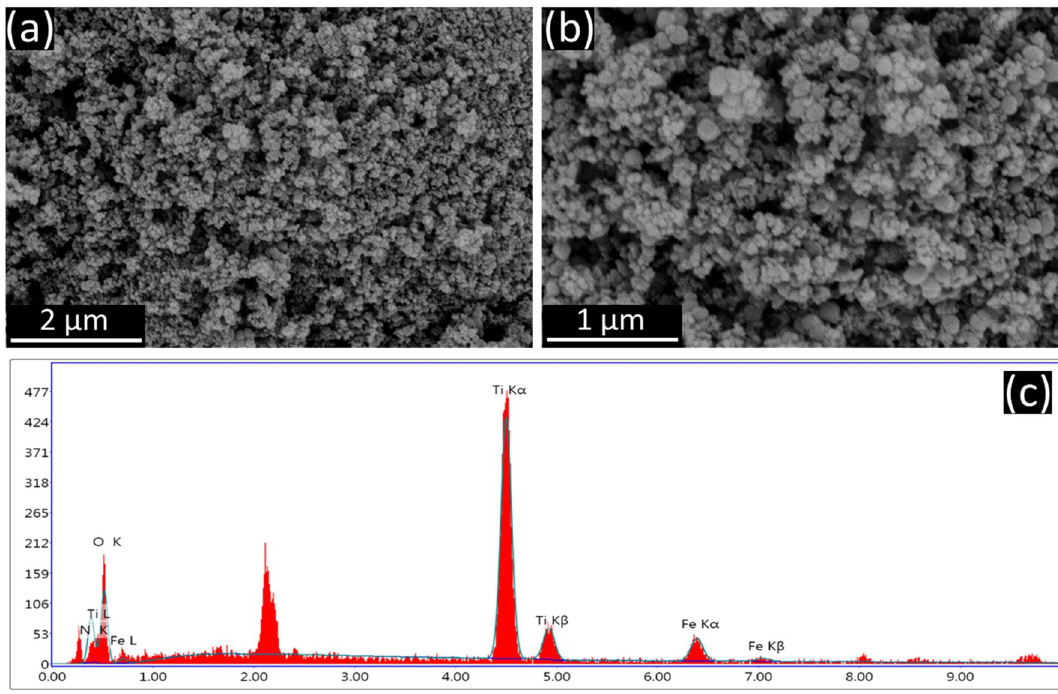
Figure 3. ( a , b ) SEM images and ( c ) EDX spectrum of 4%wt n-TiO 2 @α-Fe 2 O 3